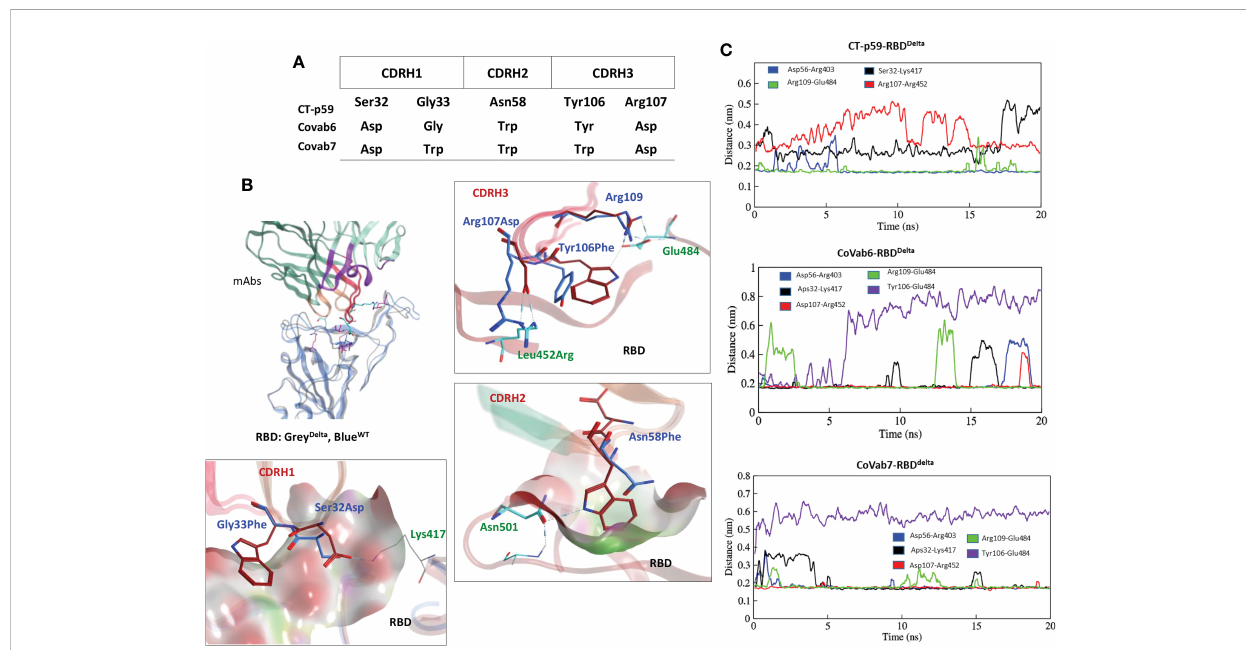
FIGURE 5 CDR diversi fi cation and interface analysis of the CoVAb-RBD complexes. (A) Contact favorable mutations created in CT-p59 CDRs to restore their ef fi cacy against the Delta variant. (B) Interface analysis of the CoVAb6-RBD and CoVAb7-RBD complexes. Salt bridges between Arg452 and Asp107 are restored after Arg107Asp substitution in CDRH3 of CT-p59. Interface contacts along with their bonds-length, bonds-energies and bonds-type of CoVAb6-RBD Delta and CoVAb7-RBD Delta , corresponding to fi gure 5B are listed in Table S7. (C) Changes in the hydrogen bonds and salt bridges during